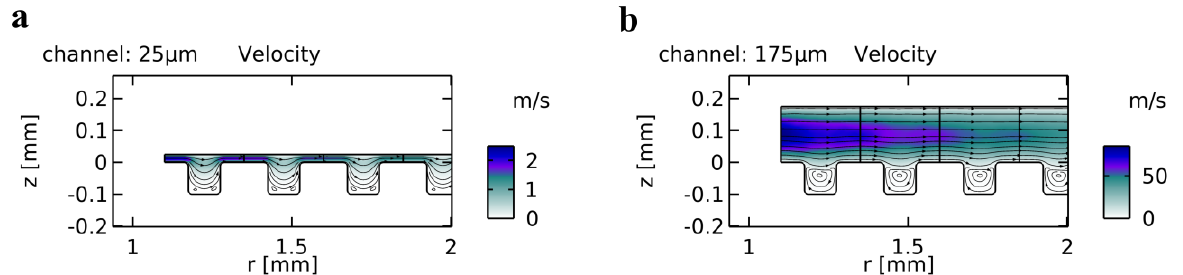
Figure 5. ( a ) Velocity field of the flow for a channel height of 25 µm. ( b ) Velocity field of the flow for a channel height of 175 µm. Vortices develop inside the trenches, having impact on the fluidic resistance; however, this impact decreases with increasing channel height.